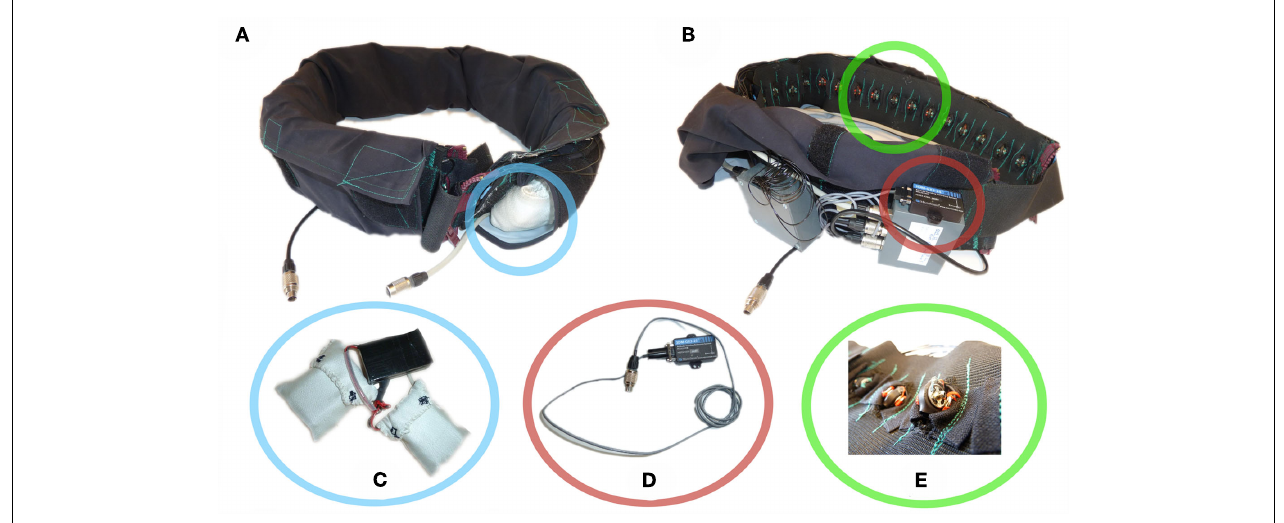
covered with flameproof fabric to exclude any danger for the subject and allowed continuous operation of the belt during a whole day. (D) The compass (MicroStrain, model 3DM-GX3-25) is attached to one of the control boxes. (E) The vibration elements were buttoned into the flexible band with pressure buttons that at the same time served as current